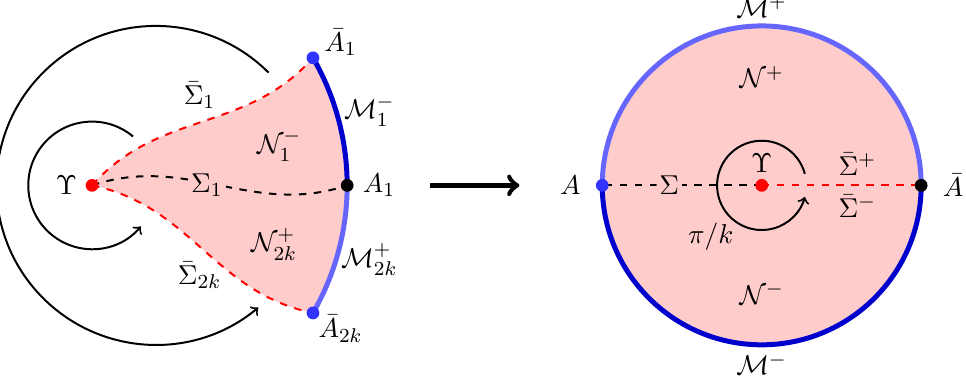
Figure 8. S ( k ) may be understood in terms of the on-shell action for a bulk manifold N with a conical defect of opening angle (cid:25)=k at (cid:7). This manifold is constructed by identifying (cid:22)(cid:6) (cid:0) = (cid:22)(cid:6) 1 with (cid:22)(cid:6) + = (cid:22)(cid:6) 2 k in N (cid:0) [ N + . 1 2 k for a conical singularity of opening angle (cid:25)=k at (cid:7). This is demonstrated in (cid:12)gure 8. As k ! 1 , this conical singularity goes away, and we are left with just the action evaluated 2 on the on-shell bulk (cid:12)eld con(cid:12)guration matching the boundary conditions of (cid:26) ( (cid:21)